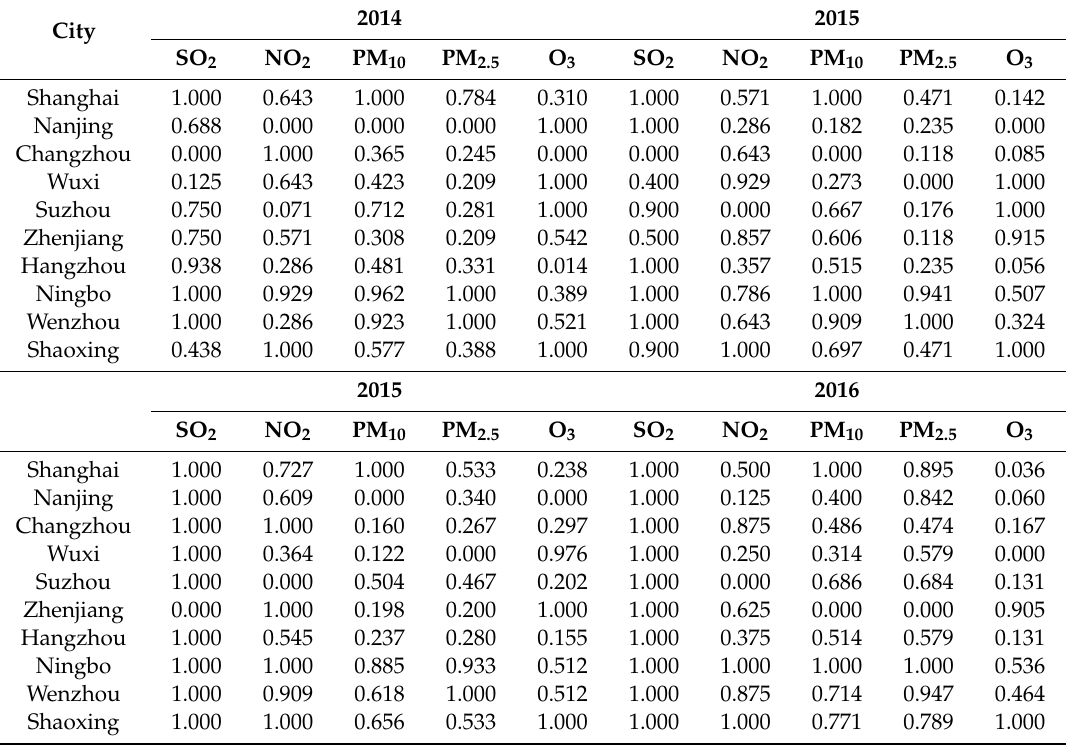
Table 4. The conversion value of